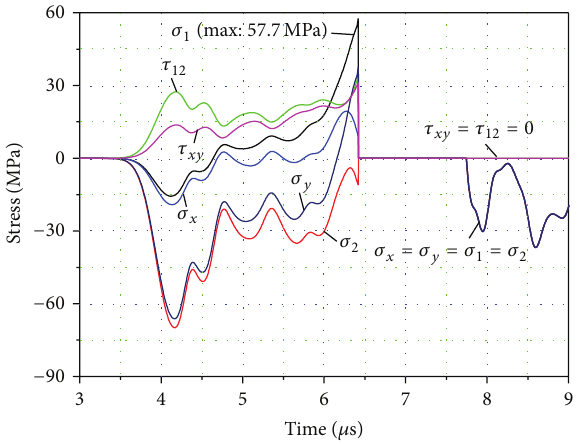
Figure 7: Stresses change of the element containing point 4.